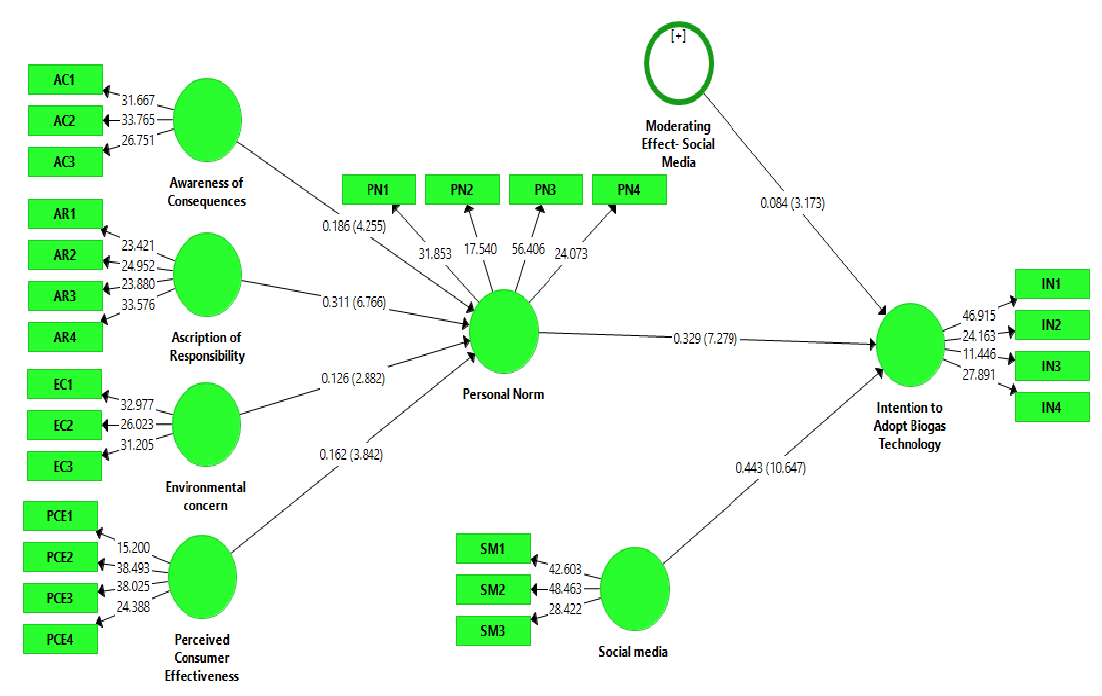
ff ect of social